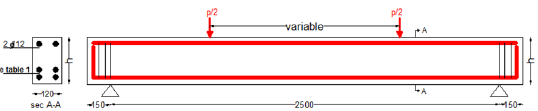
The tested RC beams were divided into fifth groups; Group one study the behavior of pure steel reinforcement beams and pure GFRP reinforcement beams. two RC tested beams with bottom steel bars (4ϕ10, 4ϕ12), And one RC tested beam with GFRP bars (4#4). Group two study the reinforcement configuration and ratios have three tested beams with bottom reinforcement (2ϕ10, 2#3), (2ϕ12, 2#4), and (2ϕ10, 2#5). The third group study size effect, and has two tested RC beams with depth(200mm,400mm), bottom reinforcement (2ϕ12, 2#4).